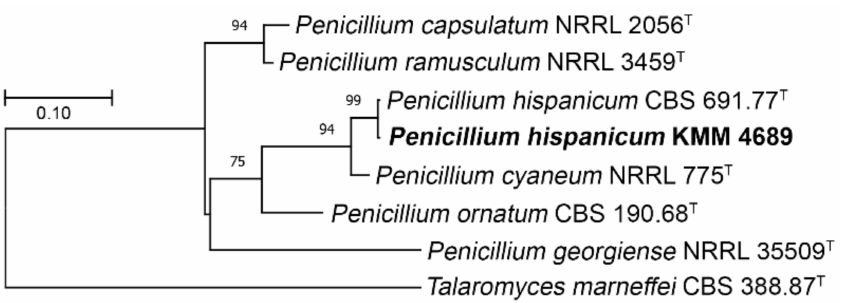
Figure 8. ML tree based on concatenated ITS region and partial β -tubulin gene sequences showing phylogenetic position of the strain KMM 4689 among members of genus Penicillium section Ramigena . Bootstrap values (%) of 1000 replications. Nodes with confidence values greater than 50% are indicated. The scale bar represents 0.1 substitutions per